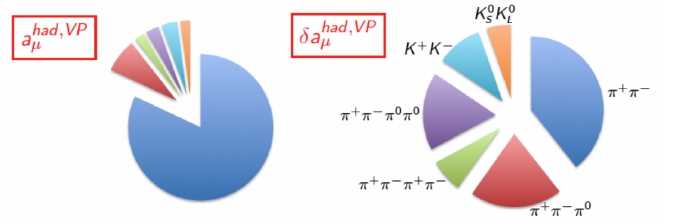
Figure 1. Contributions (left) and their uncertainties (right) of the most important hadronic cross sections, that contribute to a VP,LO µ